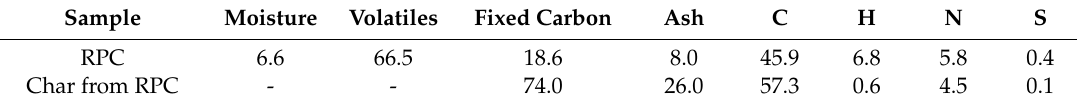
Sample Moisture